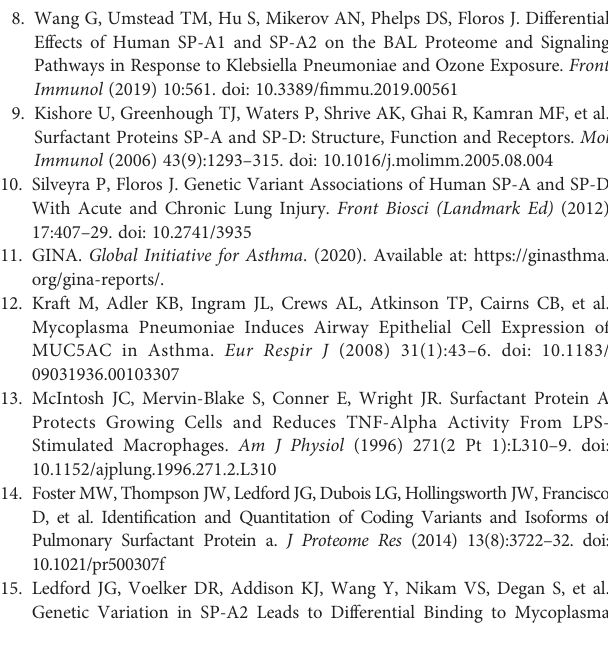
Supplementary Figure 1 | C57BL/6 negative controls. (A) BAL analysis for IL-13 model of all genotypes, (B) BAL analysis for HDM model, (C) lung function of WT males to methacholine